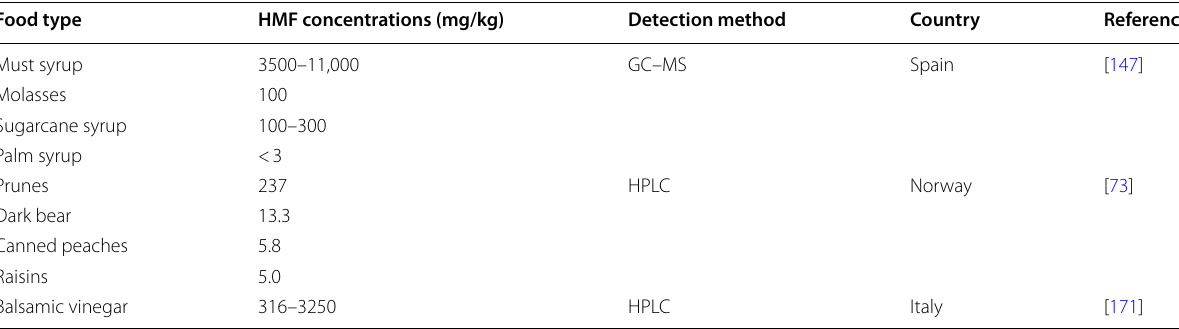
Table 2 HMF concentrations in different food